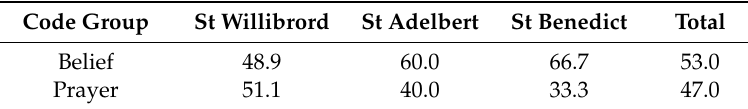
Table 13. Problems of ritual transfer—monastic context. Code Group St Willibrord St Adelbert St Benedict Total Belief